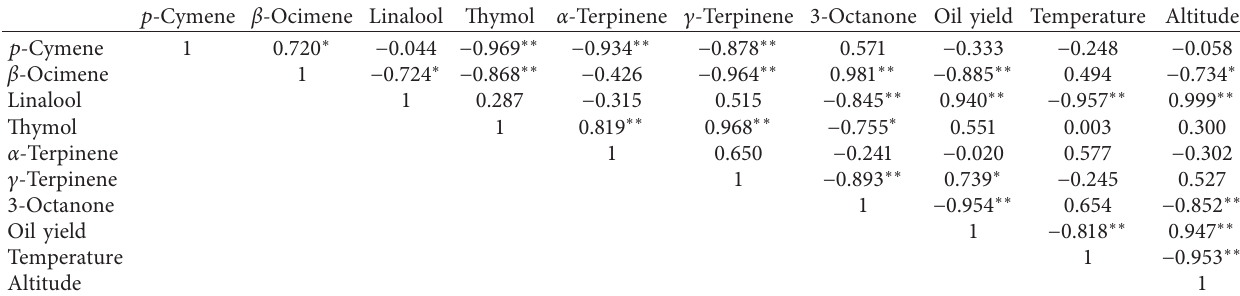
Table 6: Correlation between major components of the essential oil and the climatic condition.